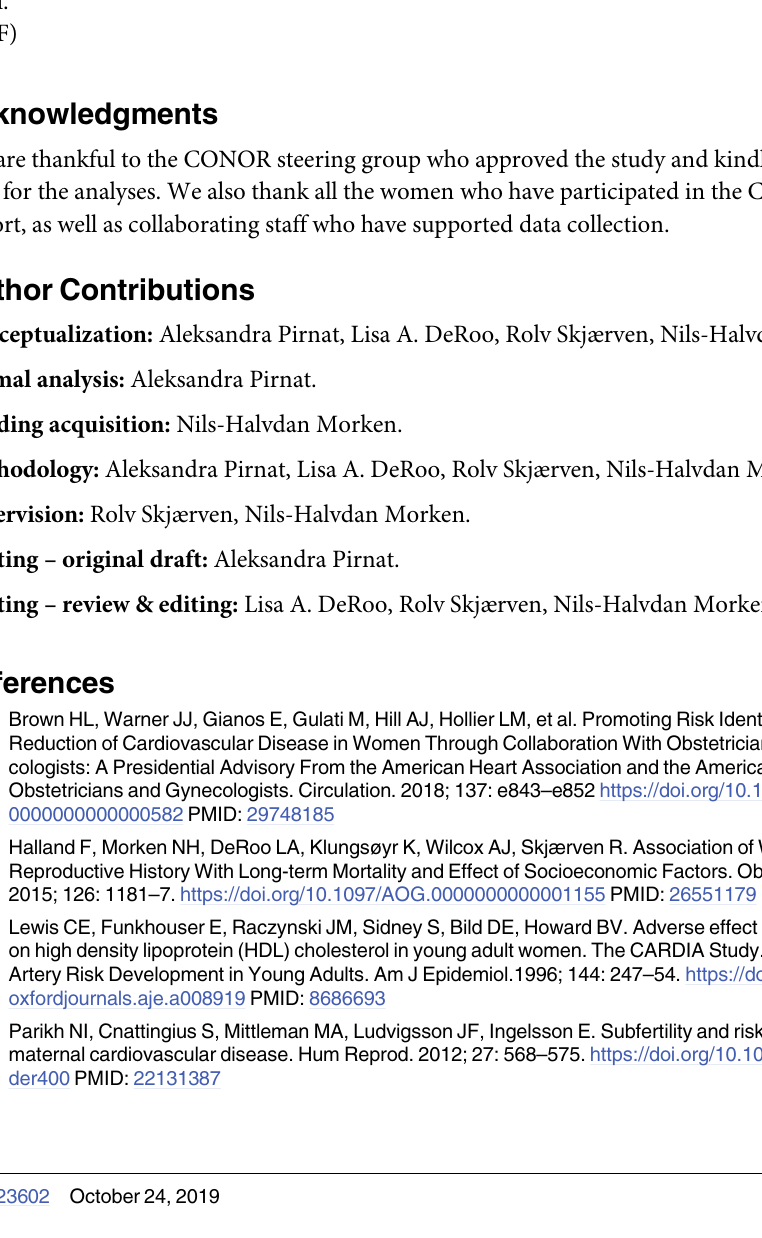
S2 Table. Adjusted odds ratio (OR) with 95% confidence interval (CI) for one lifetime pregnancy by non-HDL cholesterol quintiles in 32 618 parous Norwegian women ( � 69 years of age), Cohort of Norway, 1994–2003. Estimates were obtained by logistic regression and adjusted for age at examination, year of first birth, body mass index (linear term), oral contraceptive use, smoking, educational level and time since last meal. S3 Table. Adjusted odds ratios (ORs) with 95% confidence interval (CI) for one lifetime pregnancy by lipid quintiles in 19 744 parous Norwegian women without reported cardio- vascular disease in parents or siblings, Cohort of Norway, 1994–2003. Estimates were obtained by logistic regression and adjusted for age at examination, year of first birth, body mass index (linear term), oral contraceptive use, smoking, educational level and time since last